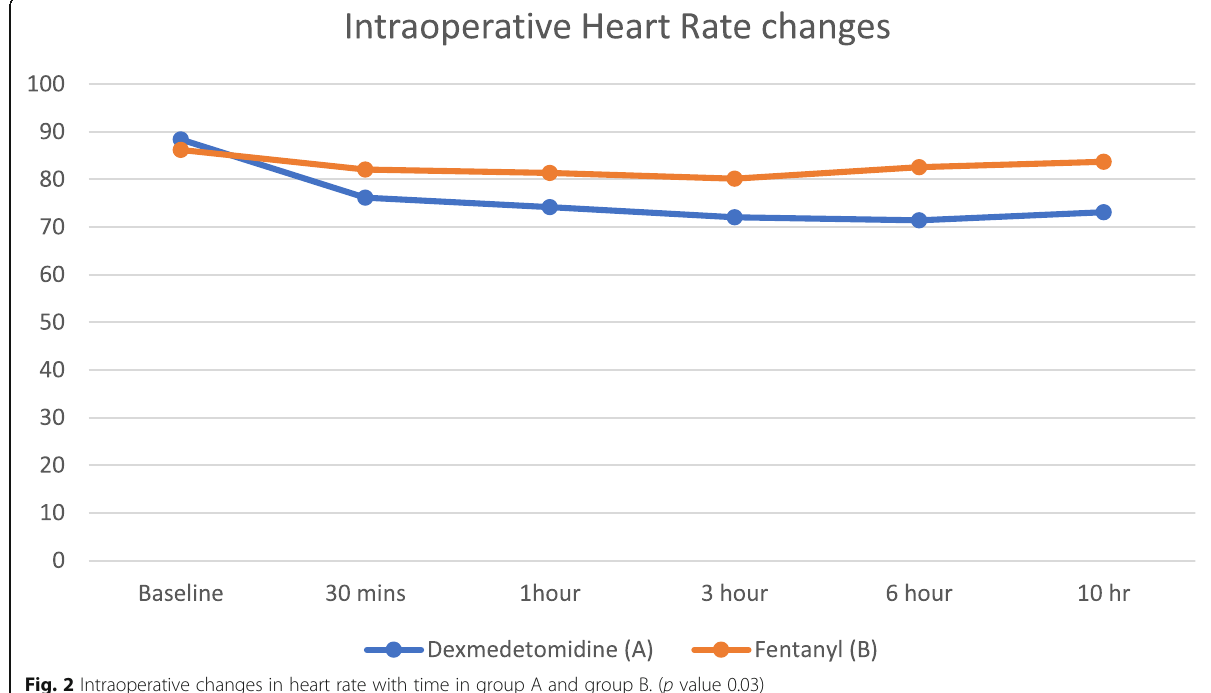
Fig. 2 Intraoperative changes in heart rate with time in group A and group B. ( p value